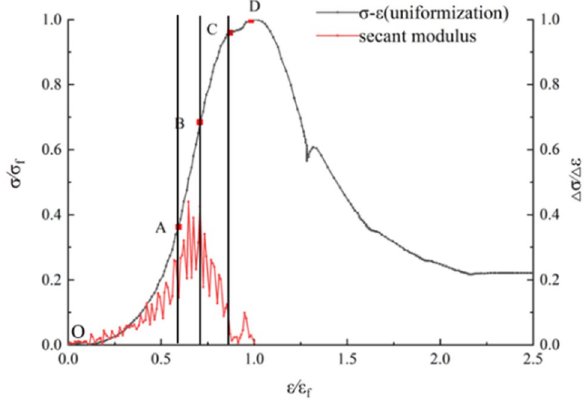
Figure 4. Stress–strain curve of the intact specimen under uniaxial compression and the determination of feature